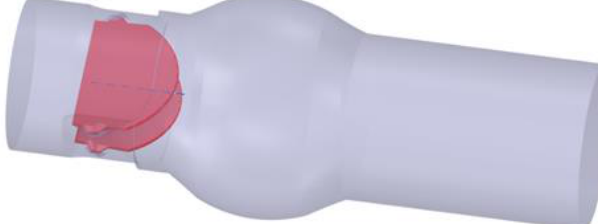
Figure 2. Fluid domain inside the ascending aorta of an MHV.